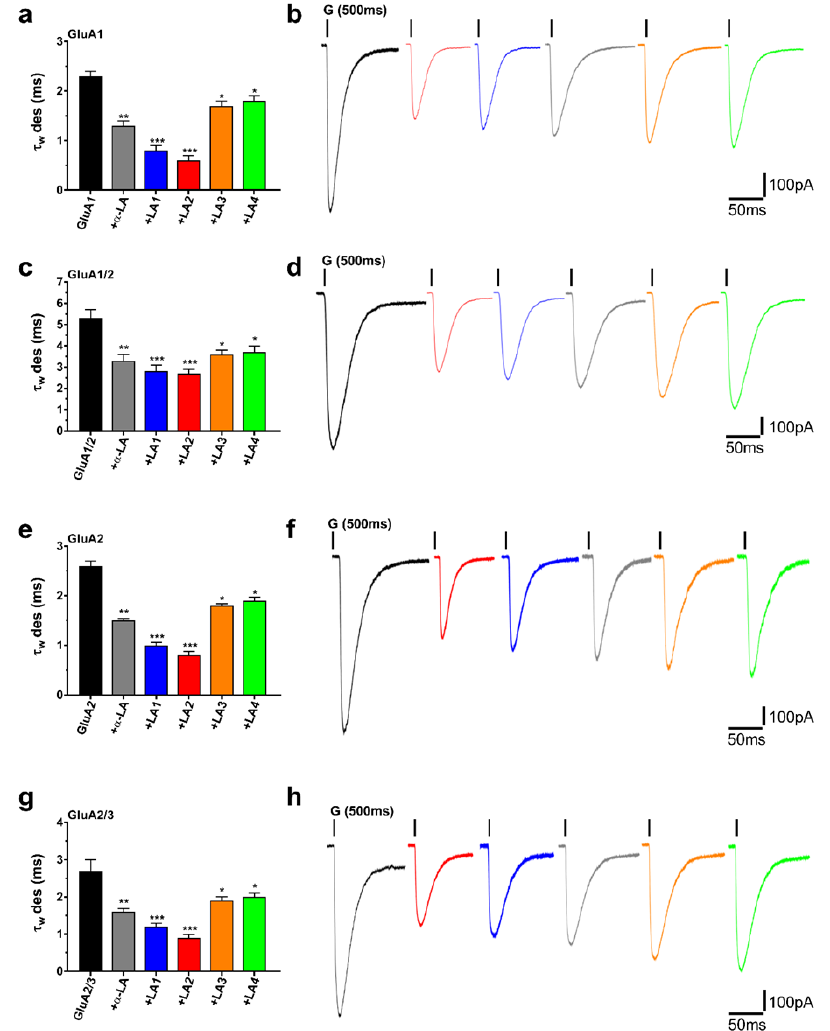
Figure 5. The effects of α -LA derivatives on AMPA receptor desensitization rate. As shown in the graphs, each subunit was influenced by the α -LA derivatives, with ( a ) representing the effect of α -LA derivatives on GluA1 desensitization rate, ( c ) representing the impacts of α -LA derivatives on GluA1/2, ( e ) representing the effects of α -LA derivatives on GluA2, and ( g ) demonstrating the effect of α -LA derivatives on the desensitization rate of GluA2/3. The traces in ( b , d , f , h ) show that α -LA derivatives substantially impacted AMPA receptor subunits. The whole-cell current was measured at − 60 mV, pH 7.4, and 22 °C. A one way analysis of variance (ANOVA) was performed for com- parison: * p < 0.05; ** p < 0.01; *** p < 0.001; ns, not significant. Ten cells were investigated for each LA derivative. The cells were rinsed for 20 s between α -LA compounds, and a 10 mM glutamate was administered alone after each α -LA compound (12 µM) to guarantee cell health, as shown in the supplementary material tables. All values are shown as mean SEM.